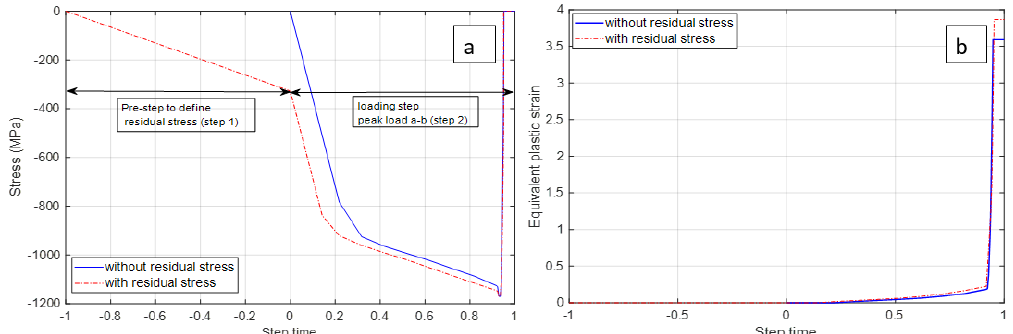
Figure 9. ( a ) Stress values versus time step and ( b ) strain versus time step for the first element precisely below the critical notch, without and with a residual stress of −80 MPa.